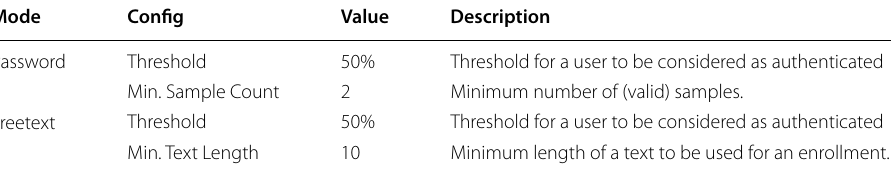
Table 8 KeyTrac API